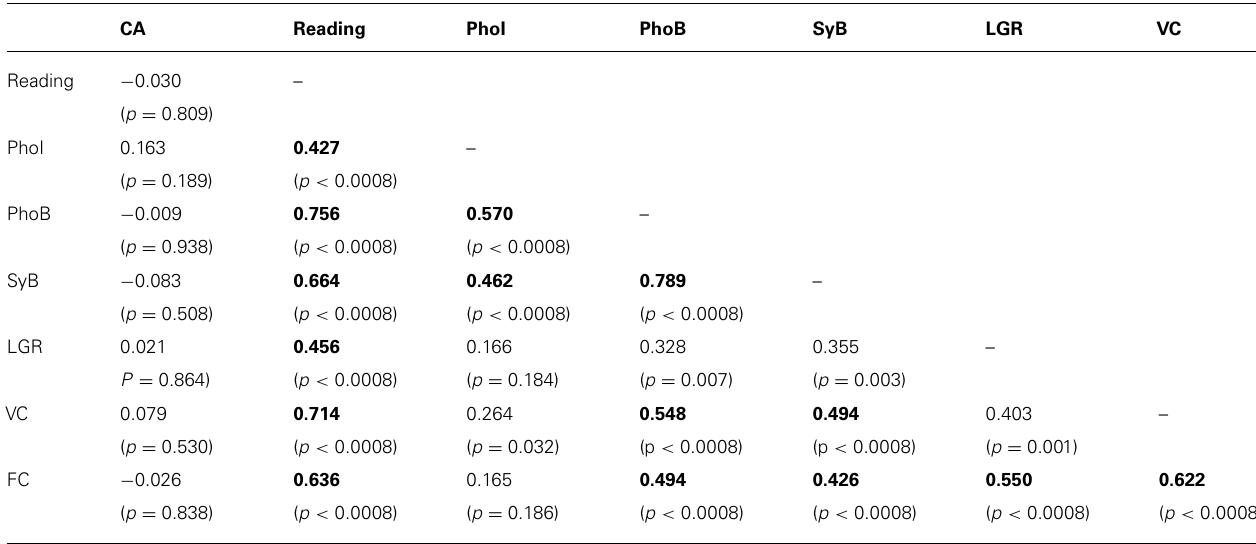
Table 3 | Correlations among age, reading, phonological awareness, and visual processing for the whole population. CA